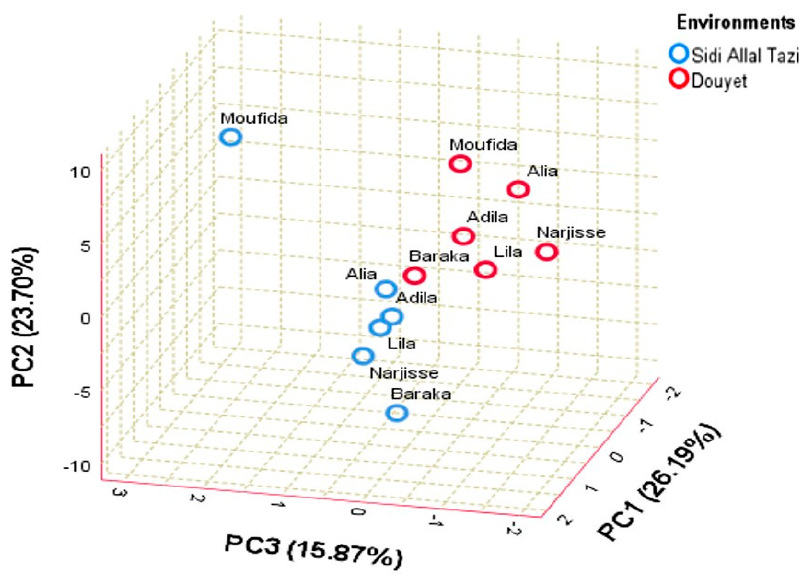
Figure 3. Principal component analysis graph for classification of the investigated rapeseed varie- ties.